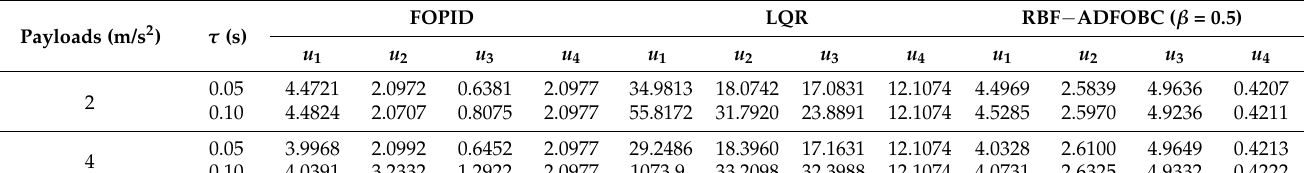
Table 20. Comparison of the root mean squared value of the control signals in the three controllers under different payloads, different input time delays and different fractional orders.